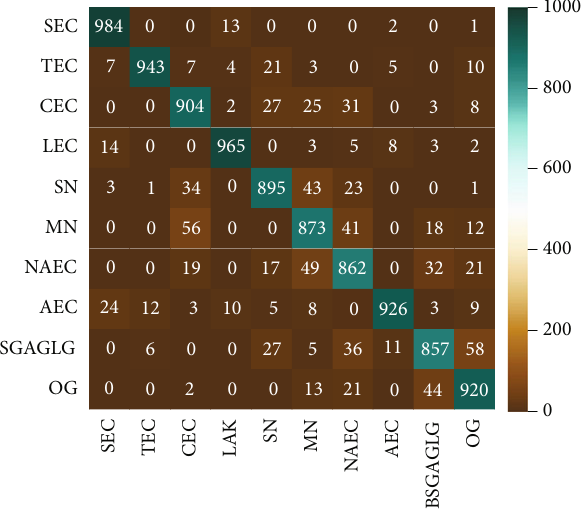
Figure 5: Confusion matrix of fusion classi fi er. Table 4: Record of loss value of each